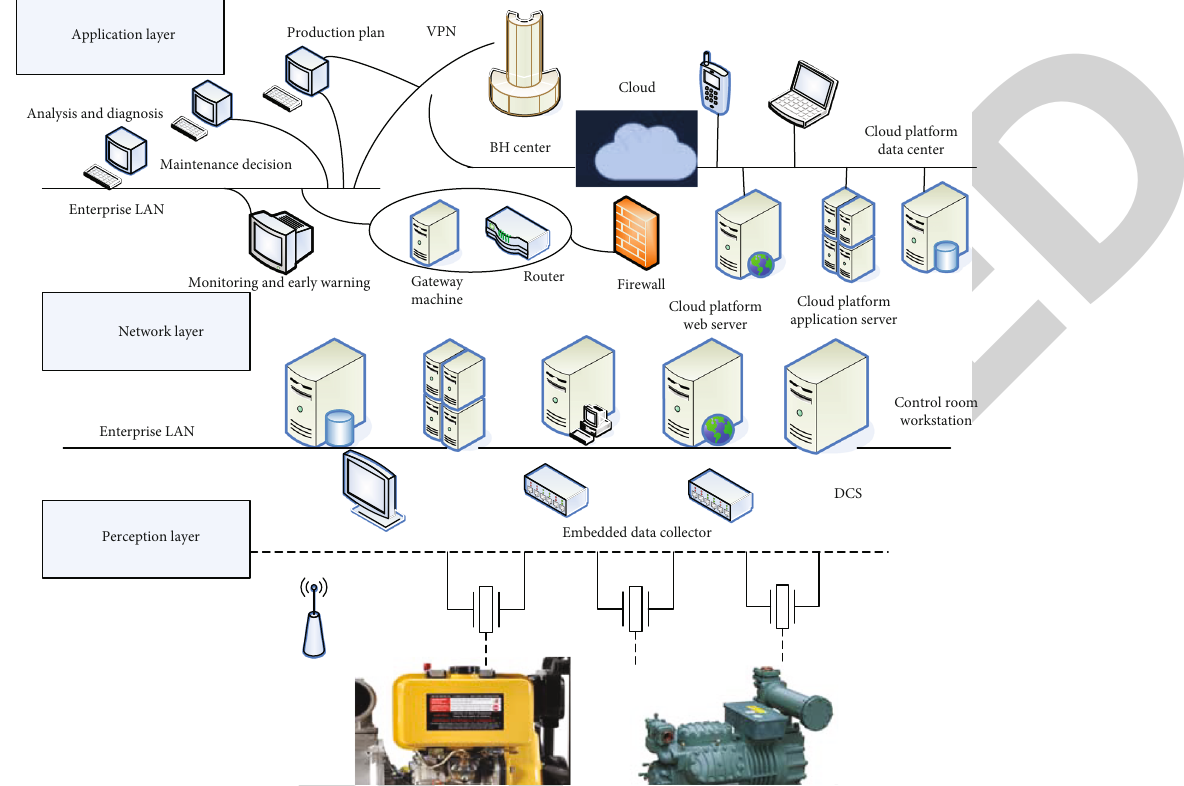
Figure 1: The three-tier structure of the Internet of